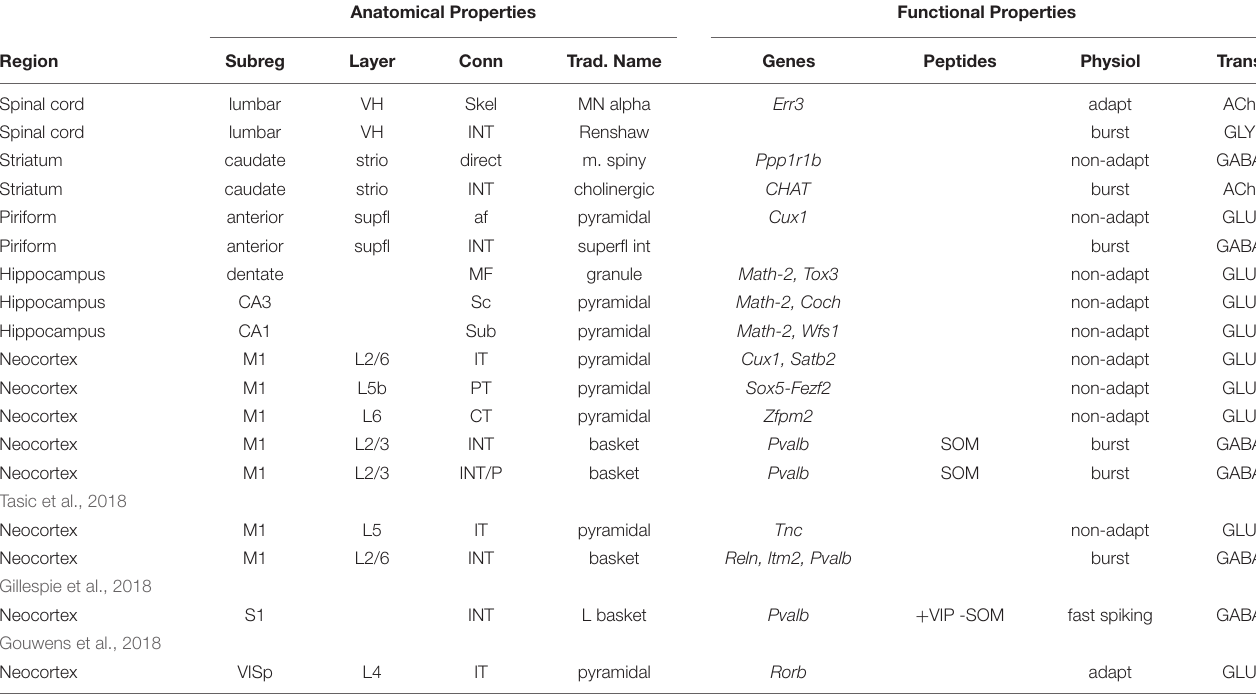
TABLE 3 | Summary of formats for anatomical and functional properties of different neuron types covered in the